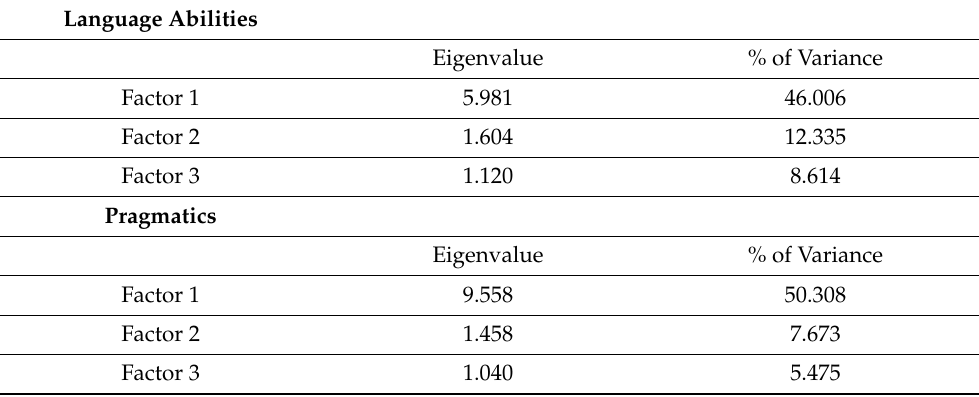
Table 2. Results of factor analyses.